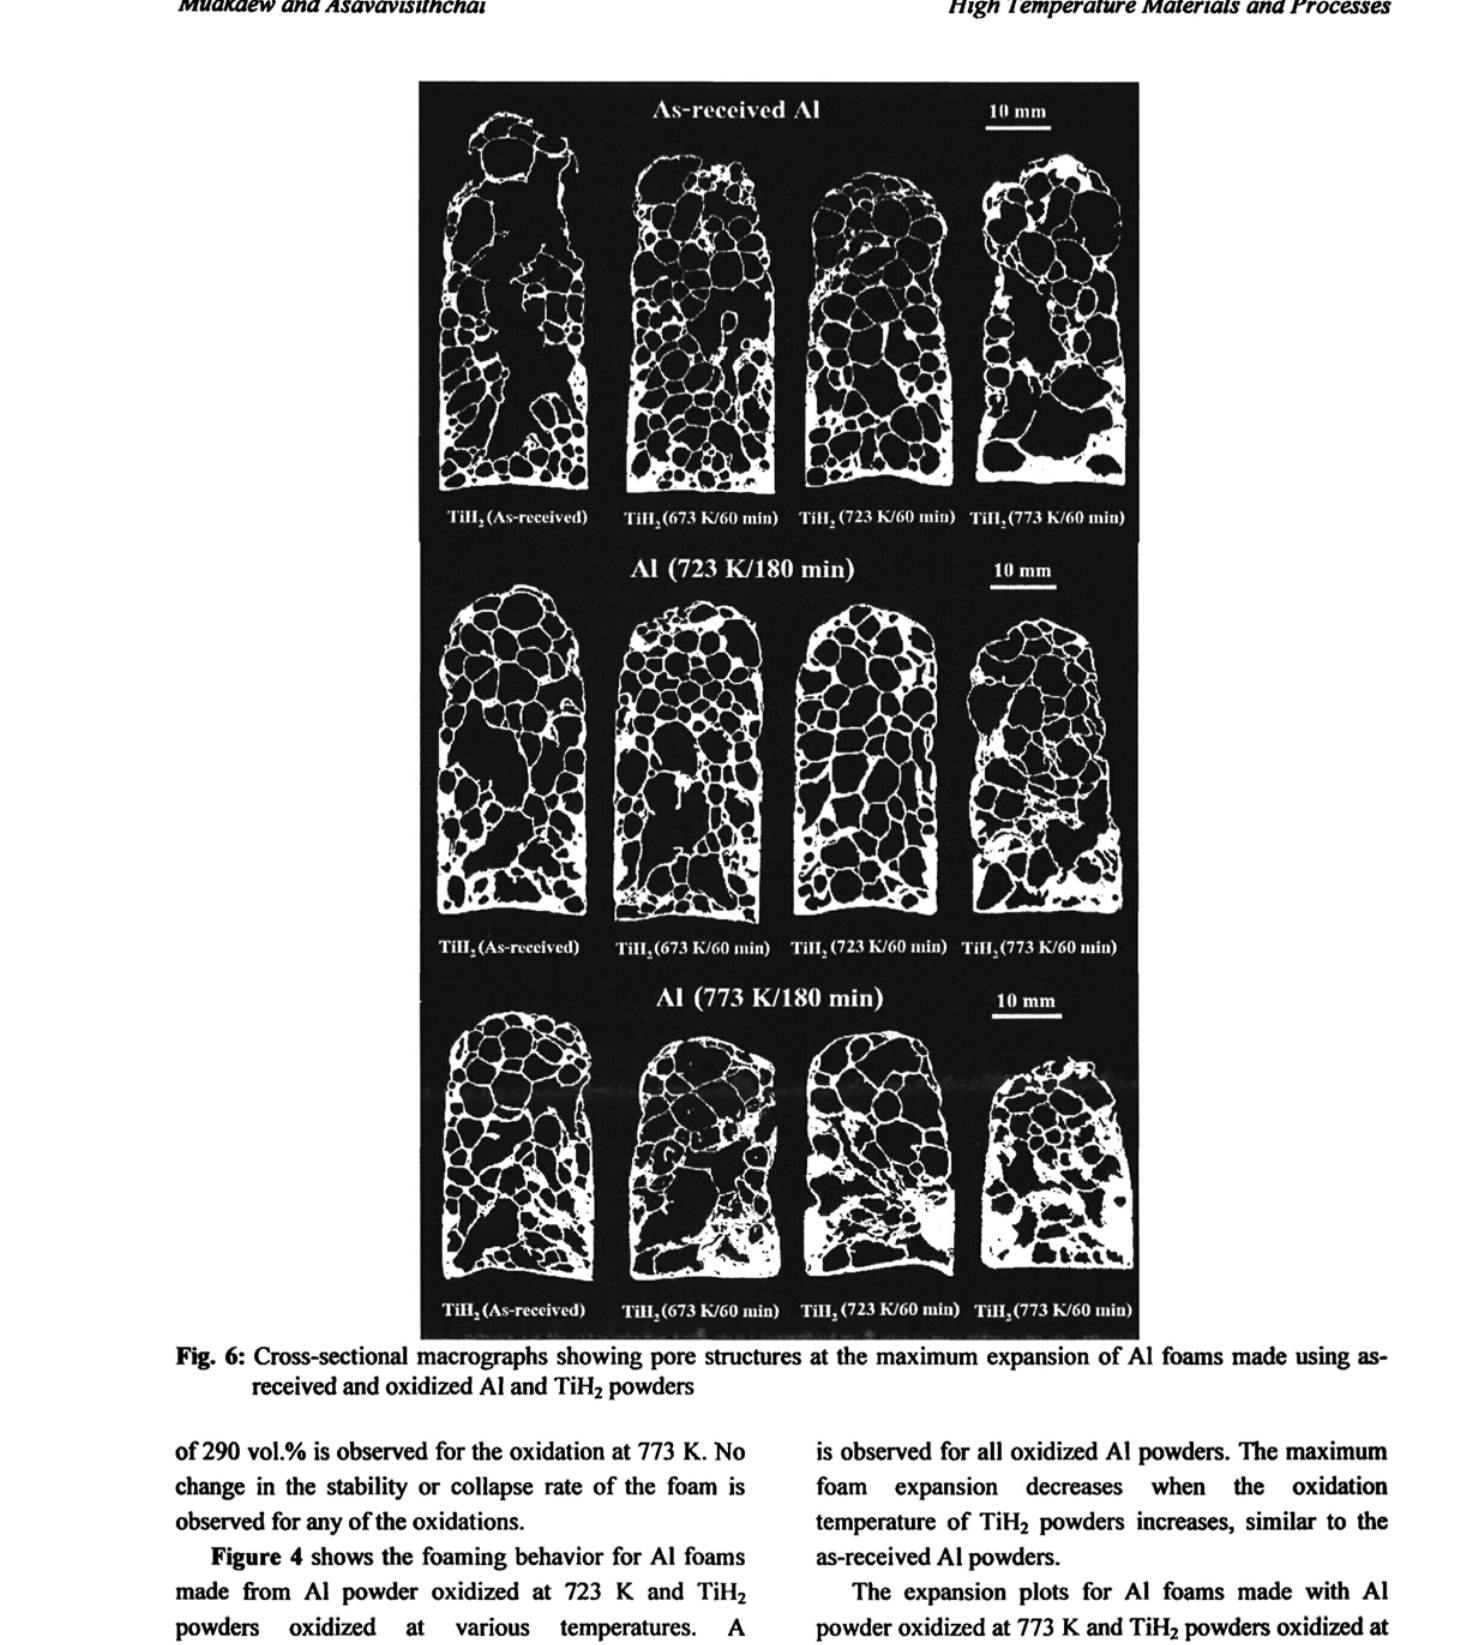
Fig. 6: Cross-sectional macrographs showing pore structures at the maximum expansion of Al foams made using as- received and oxidized Al and TiH powders 2 of 290 vol.% is observed for the oxidation at 773 K.